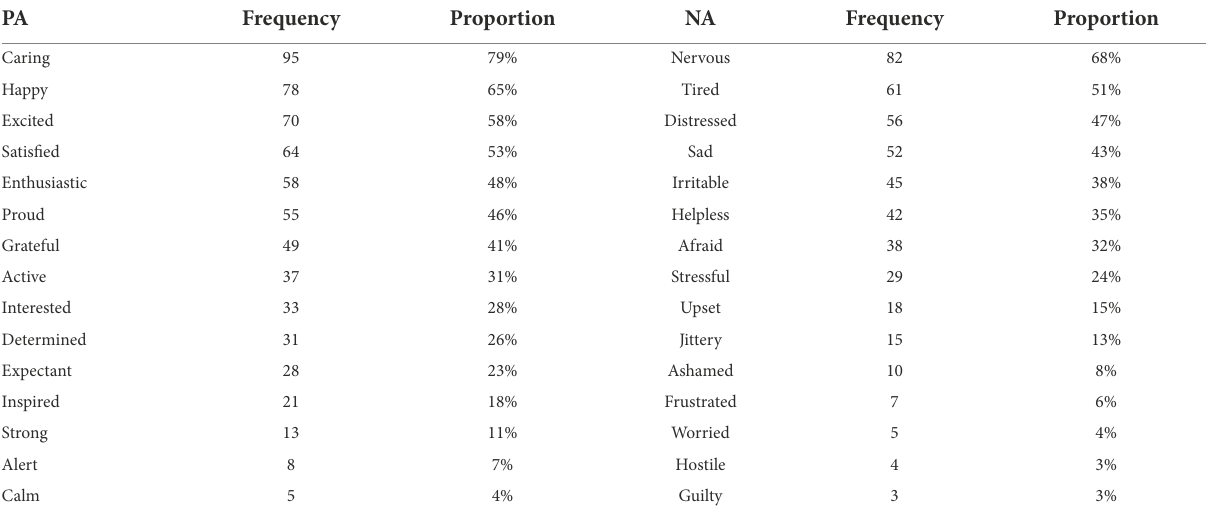
TABLE 3 Percentage of pre-service teachers who reported each emotional experience.